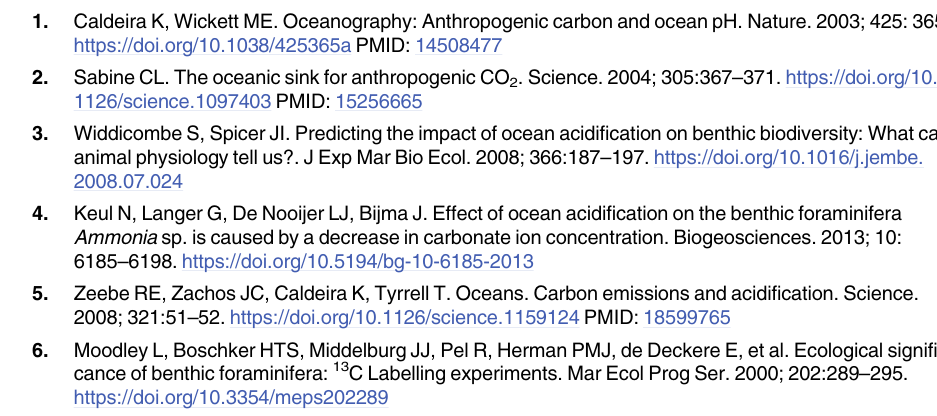
S6 Table. Seawater and carbonate system parameters for 6–week experiments (means ± standard error). Calculated parameters were calculated using CO2SYS software (version